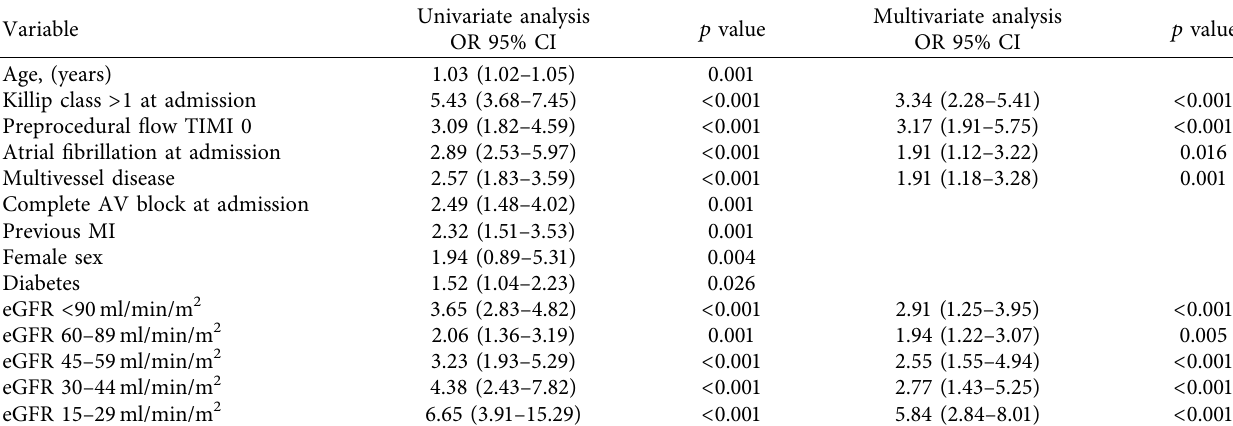
Table 3: Univariate and multivariate logistic regression analysis for the predictors of the slow-fow/no-refow